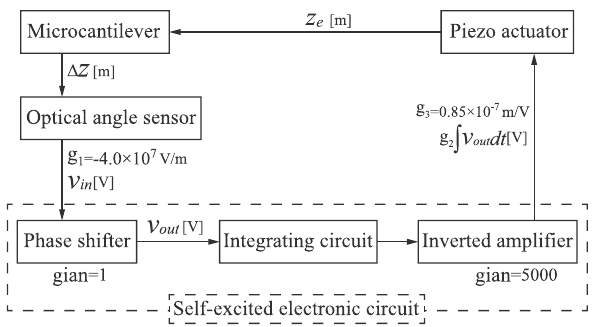
Figure 10. Block diagram of the self-excited